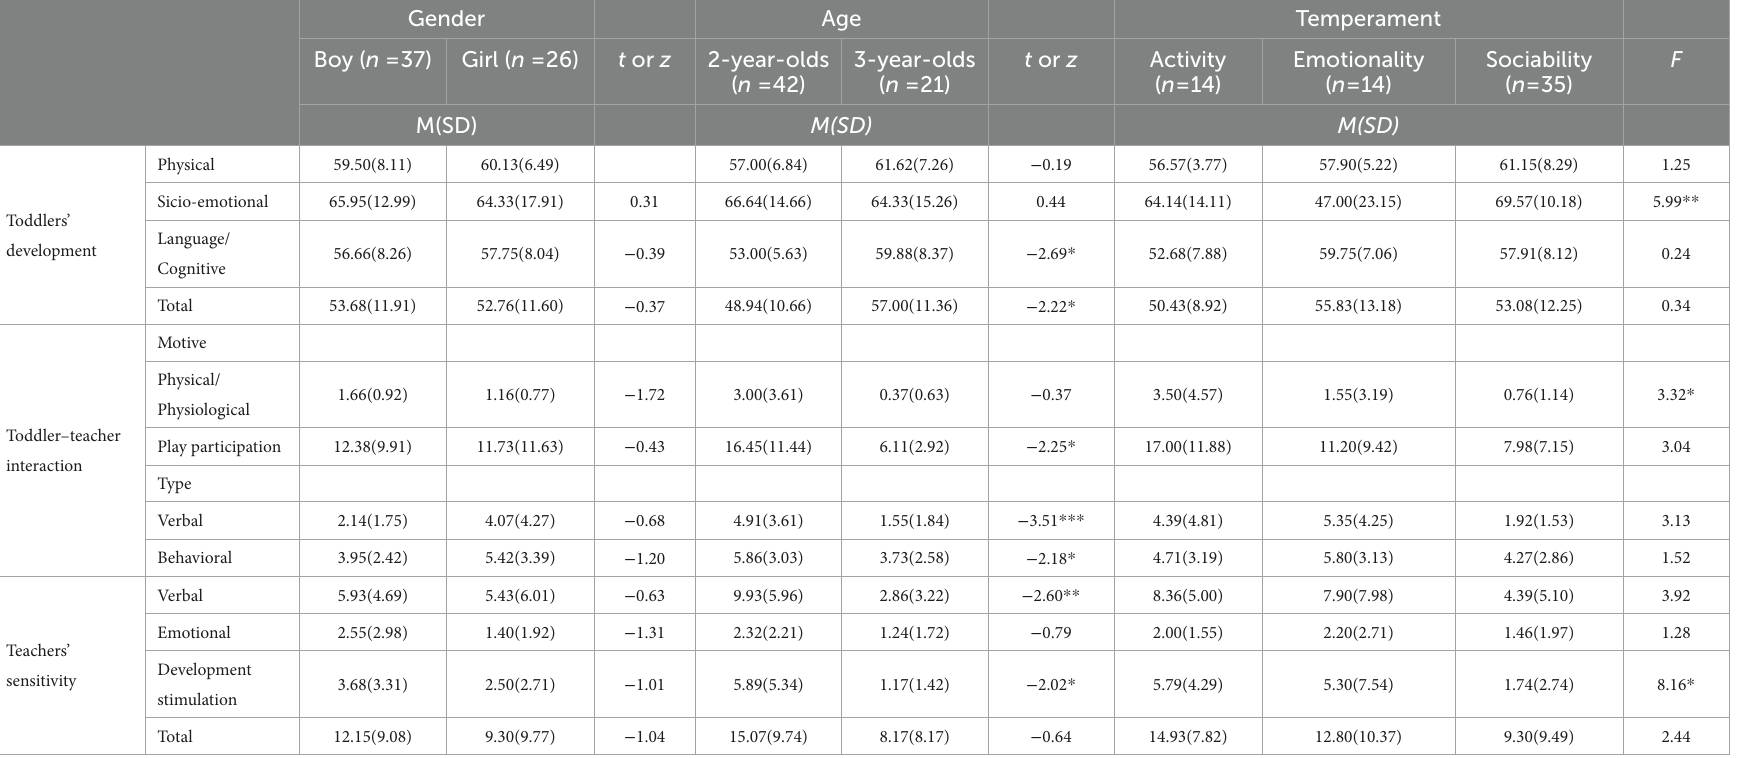
TABLE 4 Descriptive characteristics and tests of differences for study